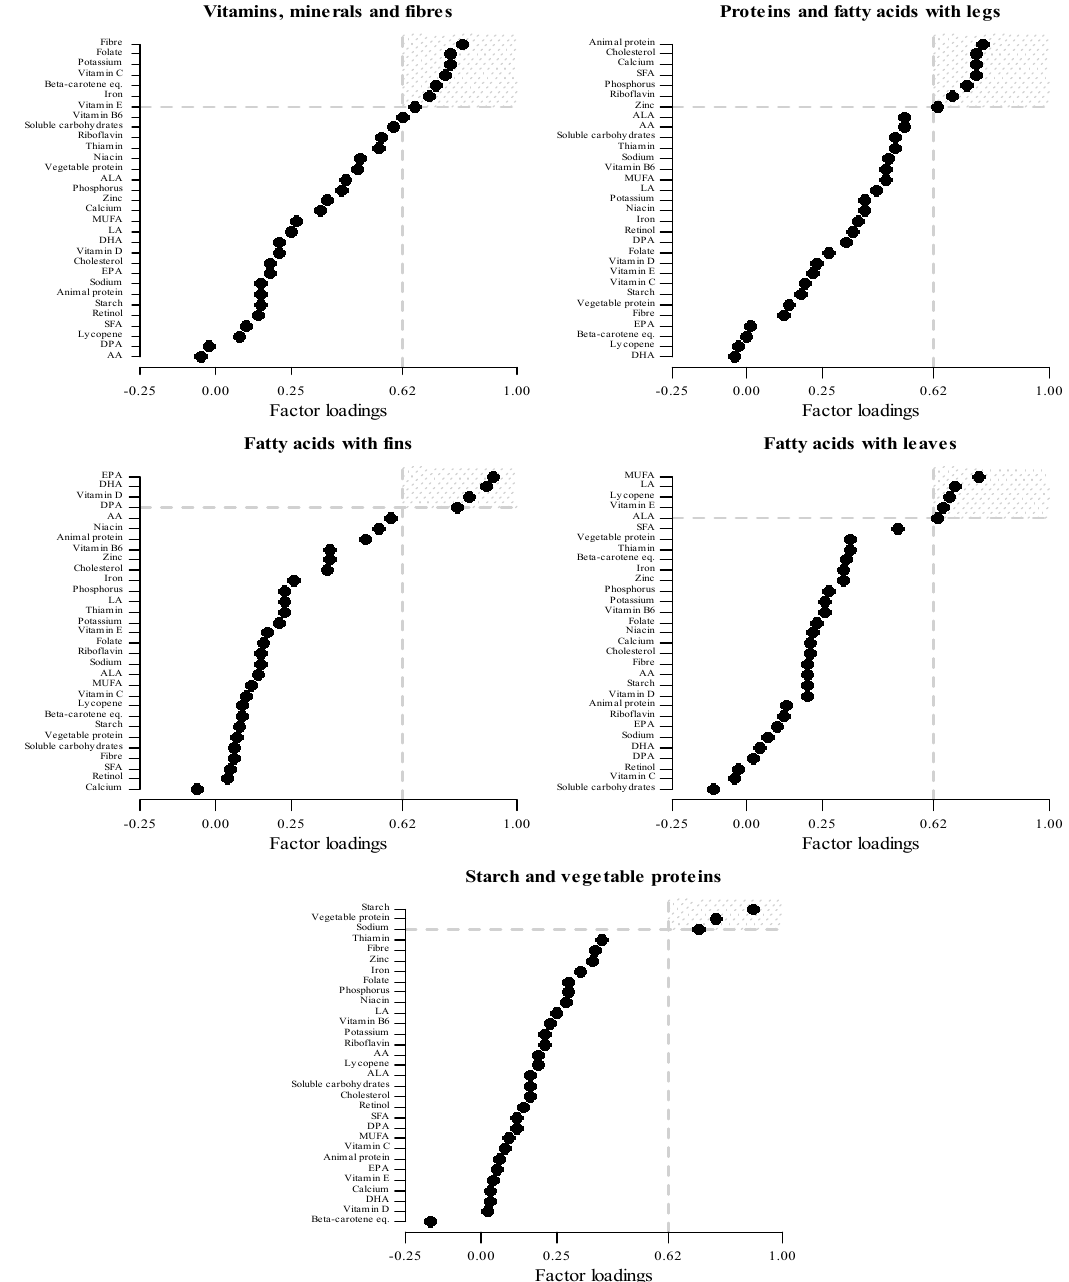
Figure 1. Nutrient’s factor loadings for the five maternal dietary patterns identified in the MEDIDIET study, using principal component factor analysis (PCFA). Estimates from PCFA performed on 31 maternal nutrient intakes. Each nutrient’s factor loading represents how strongly that nutrient is associated with dietary patterns. Nutrient’s factor loadings ≥ 0.63 represents “dominant nutrients” for each dietary pattern. AA: arachidonic acid; ALA: α -linolenic acid; DHA: docosahexaenoic acid; DPA: docosapentaenoic acid; EPA: eicosapentaenoic acid; LA: linoleic acid; MUFA: monounsaturated fatty acids; SFA: saturated fatty acids.